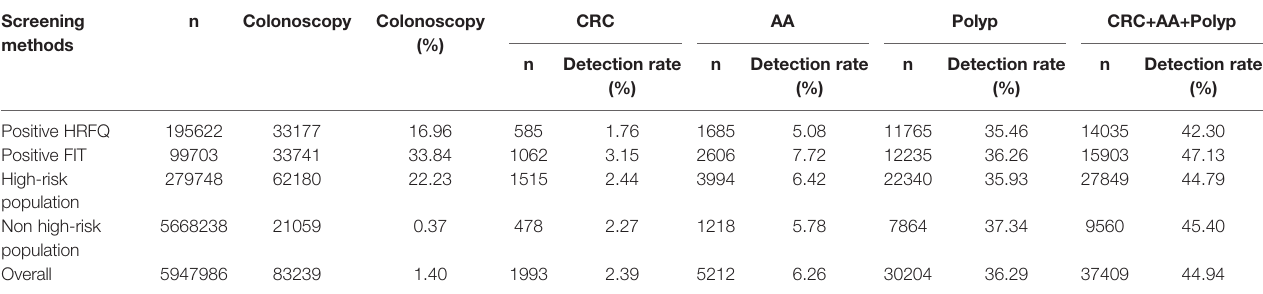
TABLE 9-1 | Distribution of colonoscopy results among different screening methods in Tianjin CRC screening program (2012-2020), (n,%). Screening